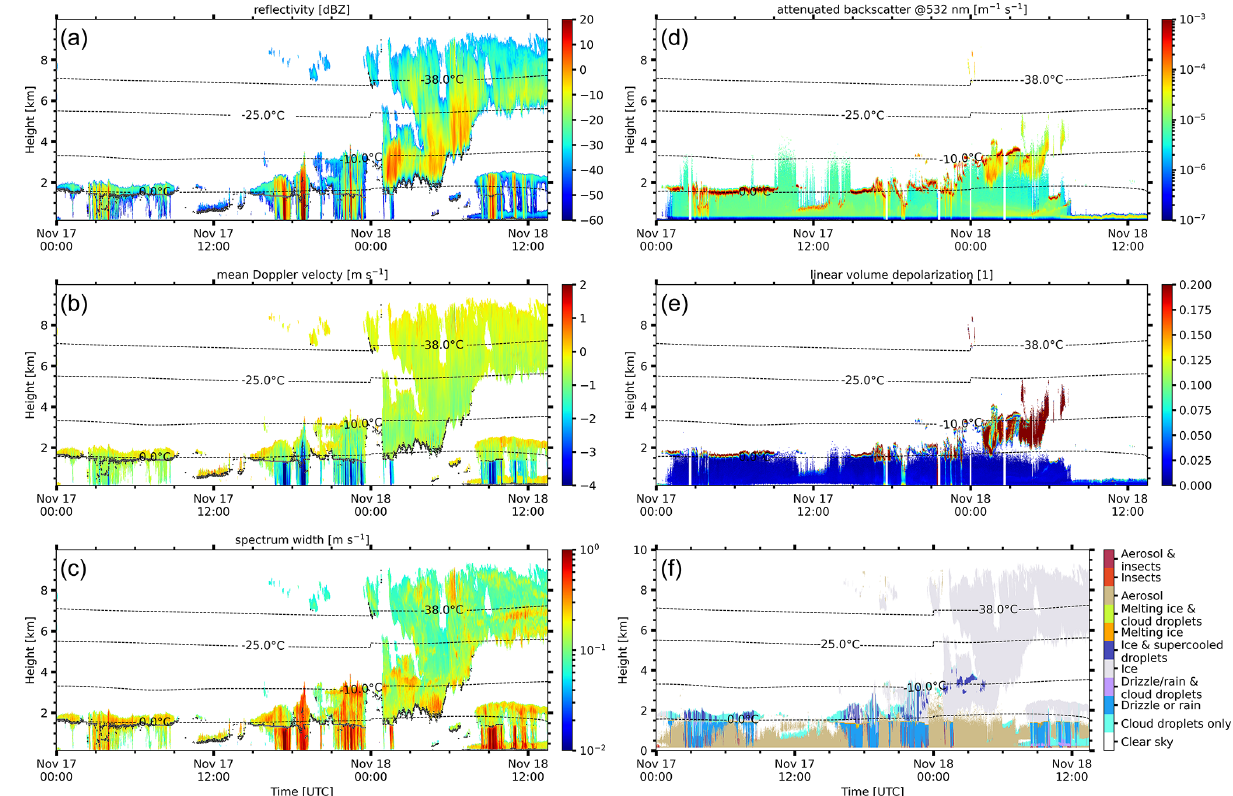
Figure 1. (a) MIRA-35 radar reflectivity factor, (b) radar mean Doppler velocity (middle), (c) radar spectrum width, (d) PollyXT lidar- attenuated backscatter coefficient at 532nm, (e) PollyXT lidar linear volume depolarization, and (f) Cloudnet target classification of 17 November 2014, 00:00UTC, to 18 November 2014, 13:30UTC, observed during the ACCEPT experiment in Cabauw, Netherlands. Black dots (a–c) indicate the first cloud base detected by the